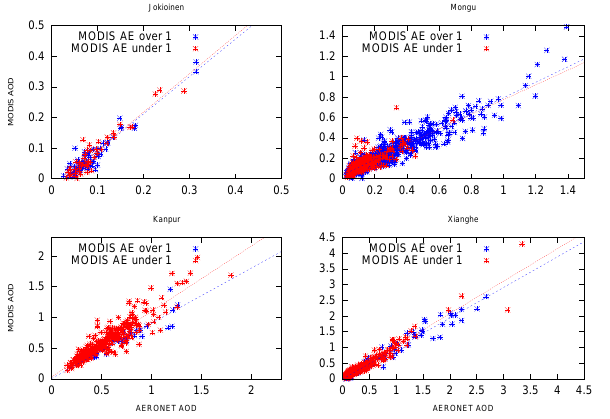
Fig. 2. Correlation of AERONET/PFR and MODIS measurements in Jokioinen, Mongu, Kanpur and Xianghe. Blue points indicate measurements with AERONET AE over 1, and red points measure- ments with AERONET AE smaller than